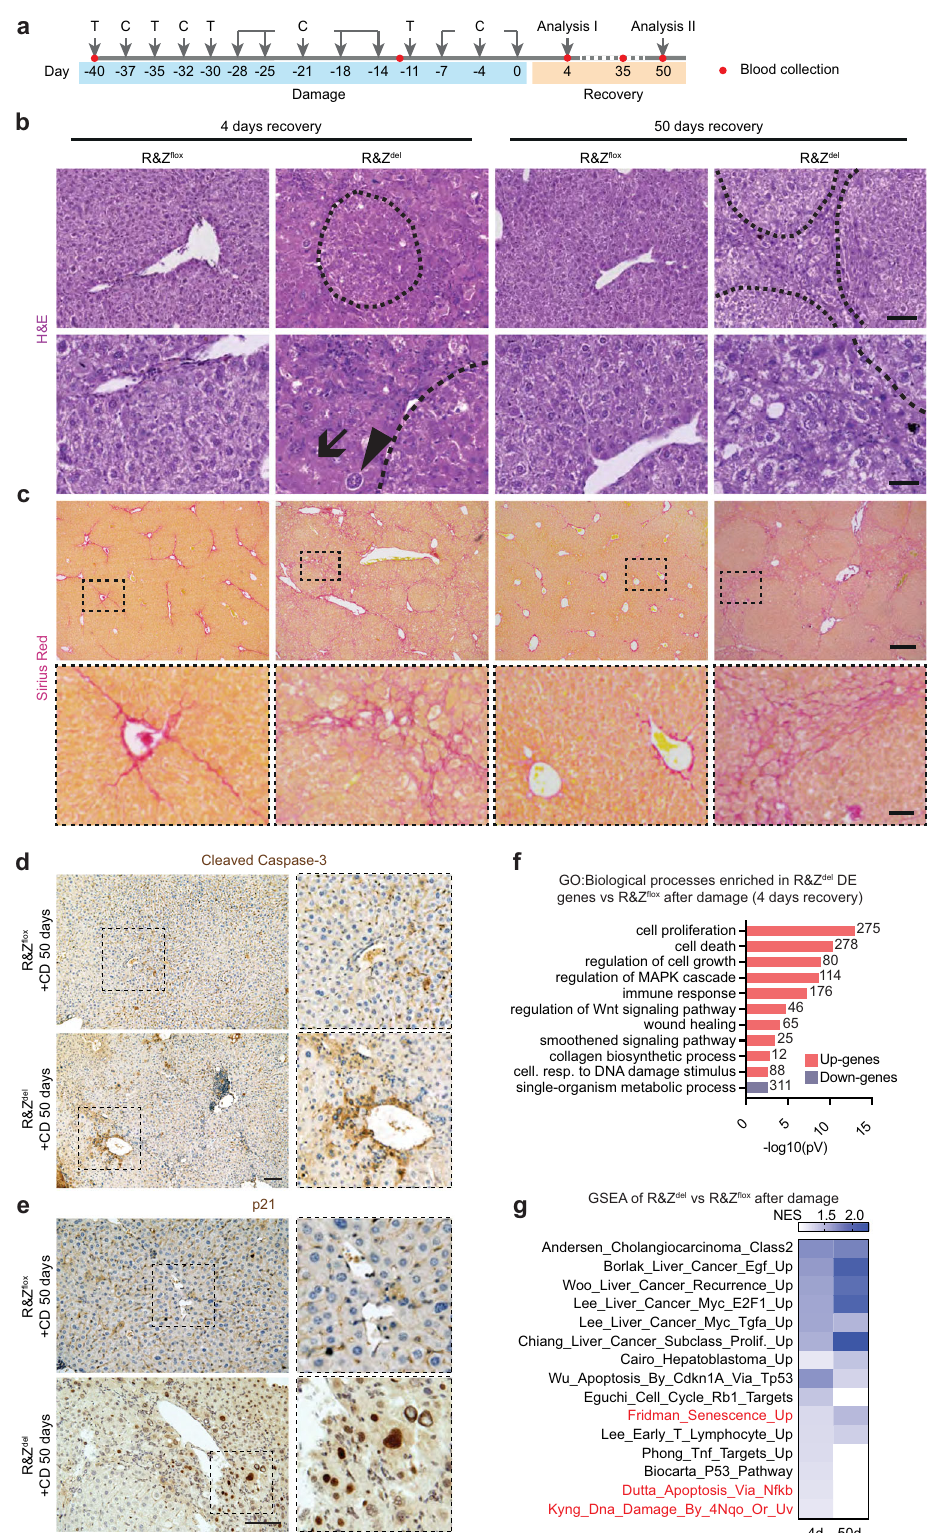
Fig. 7b – d). HCC lesions were characterised by small cells with high nuclei/cytoplasmic ratio, a compact pattern without the trabecular formation and 2-3 cell thick plates, fat accumula- tion, a signi fi cant number of proliferative (Ki67 + ) cells, neo- vascularisation and disruption of tissue histoarchitecture as evi- denced by CD34 staining, Collagen IV deposition and